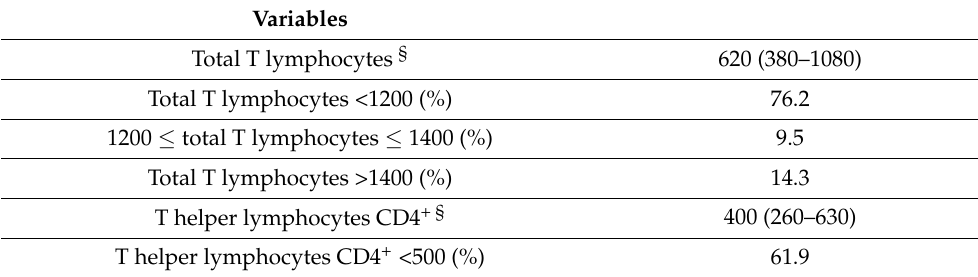
Table 3. Immune cell layout of hospitalized COVID-19